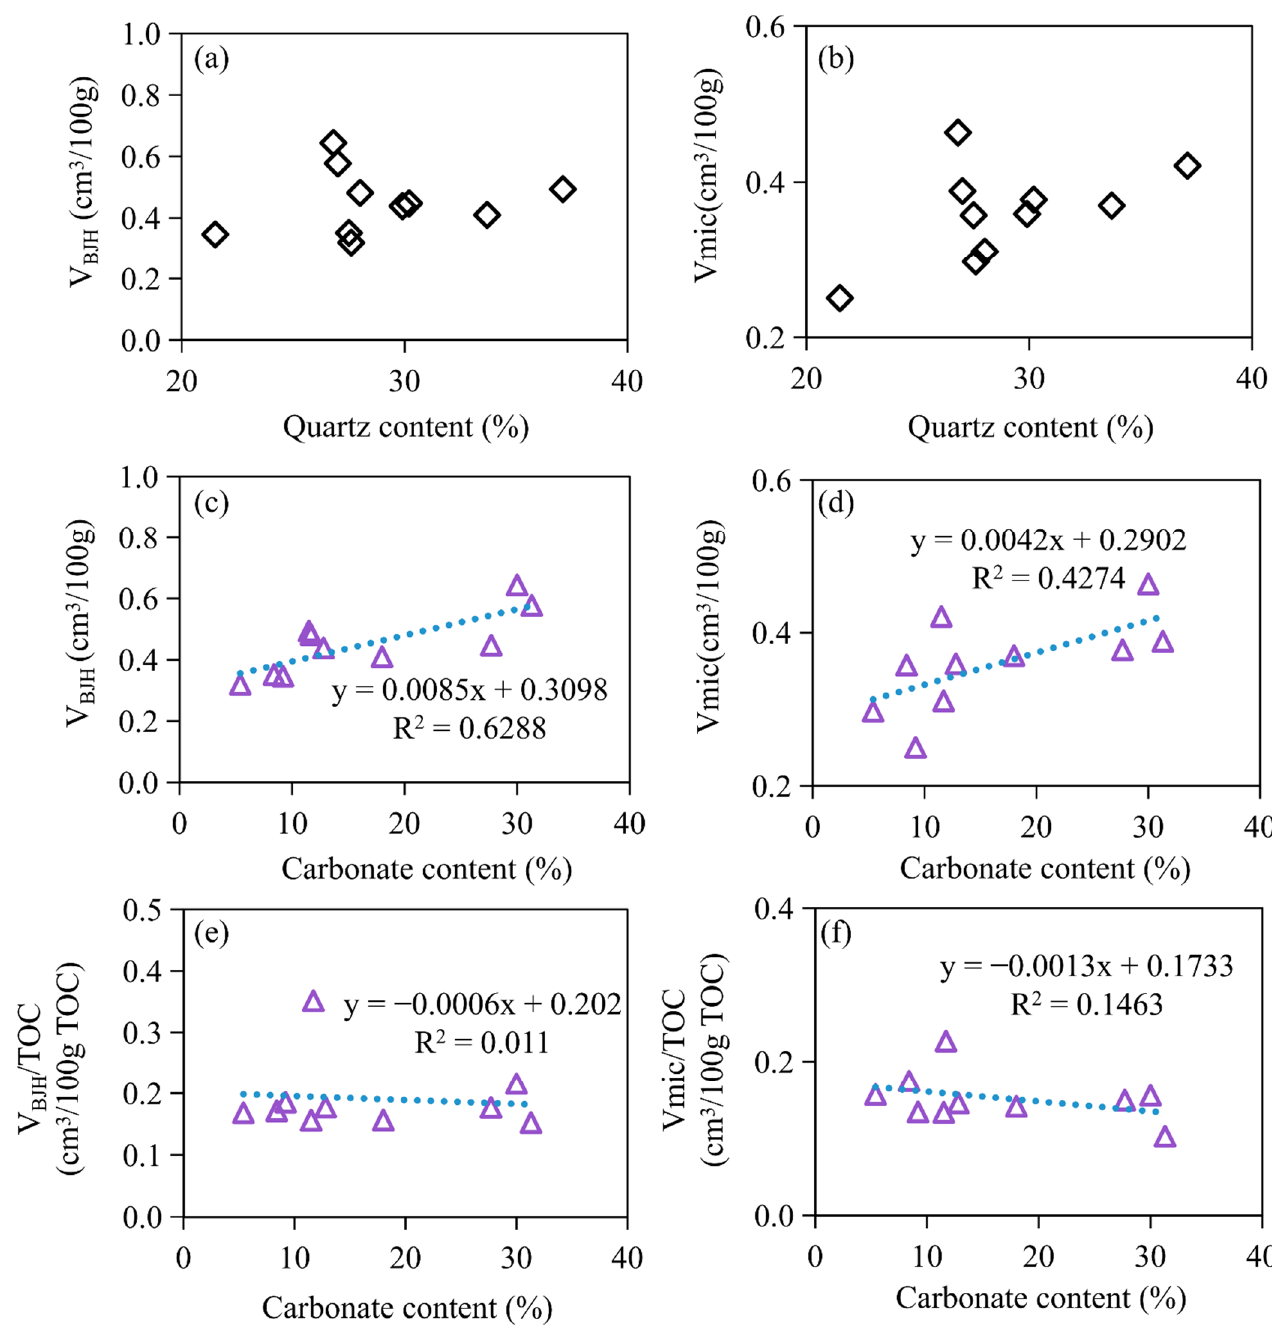
Figure 14. Relationships of quartz and carbonate content with pore structure parameters ( a – d ), and V BJH /TOC (ratio of V BJH to TOC) ( e ) and Vmic/TOC (ratio of Vmic to TOC ( f ) for the YC2 samples. See details in text.